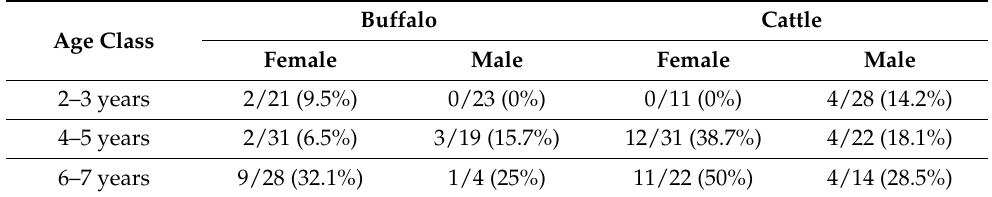
Table 3. Distribution of Echinococcus -positive sera categorised by host species, sex and age